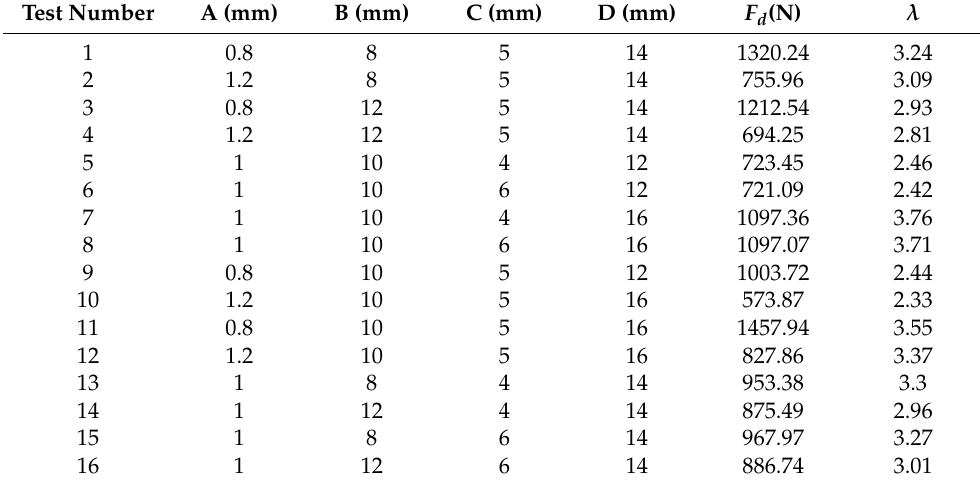
Table 4. Design and results of response surface test.